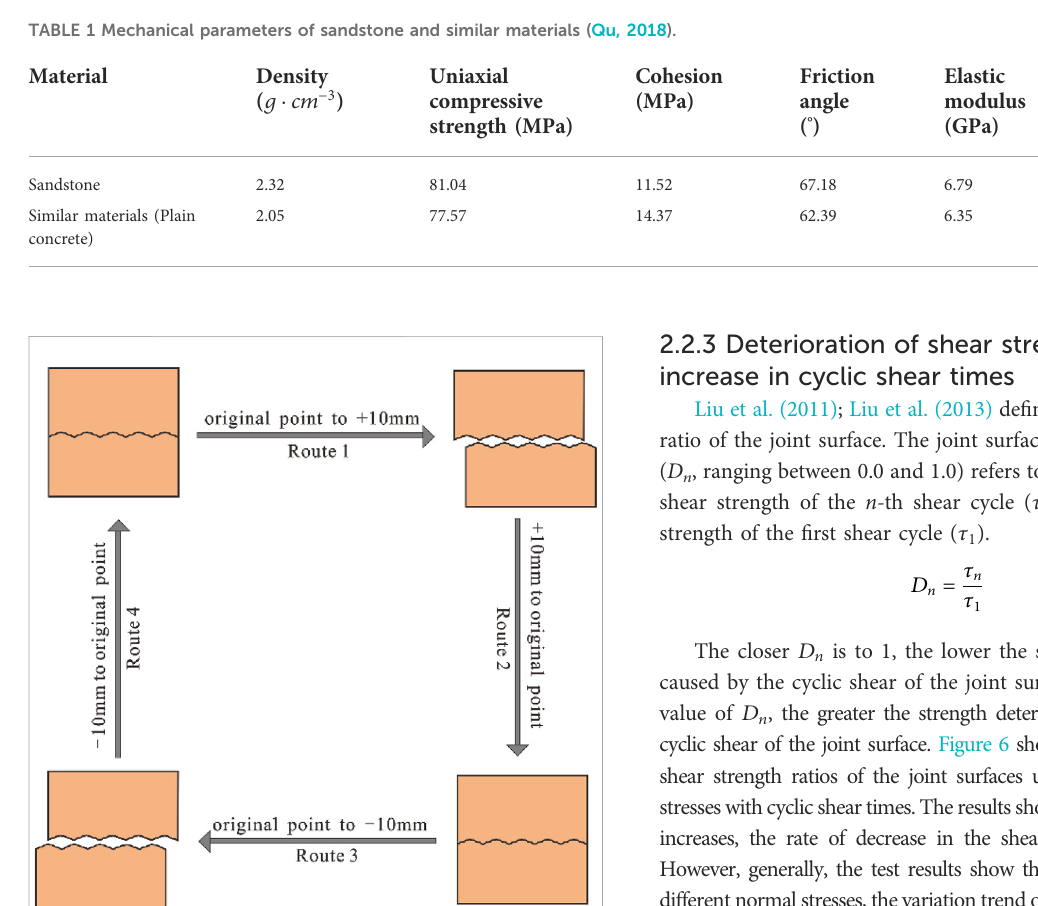
FIGURE 3 Route divisions of a single shear cycle (Qu 2018; Dong et al.,